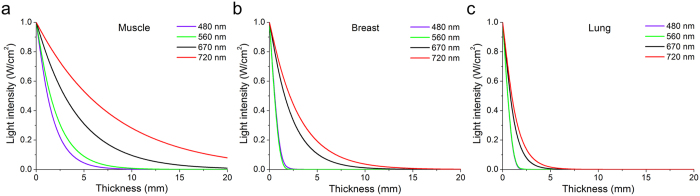
Comparison of the attenuation of the visible and NIR light in different mammalian tissues.Dependences of the light intensities at 480 nm, 560 nm, 670 nm and 720 nm wavelengths on the thickness of (a) muscle, (b) breast and (c) lung tissues were calculated as described in the Methods.